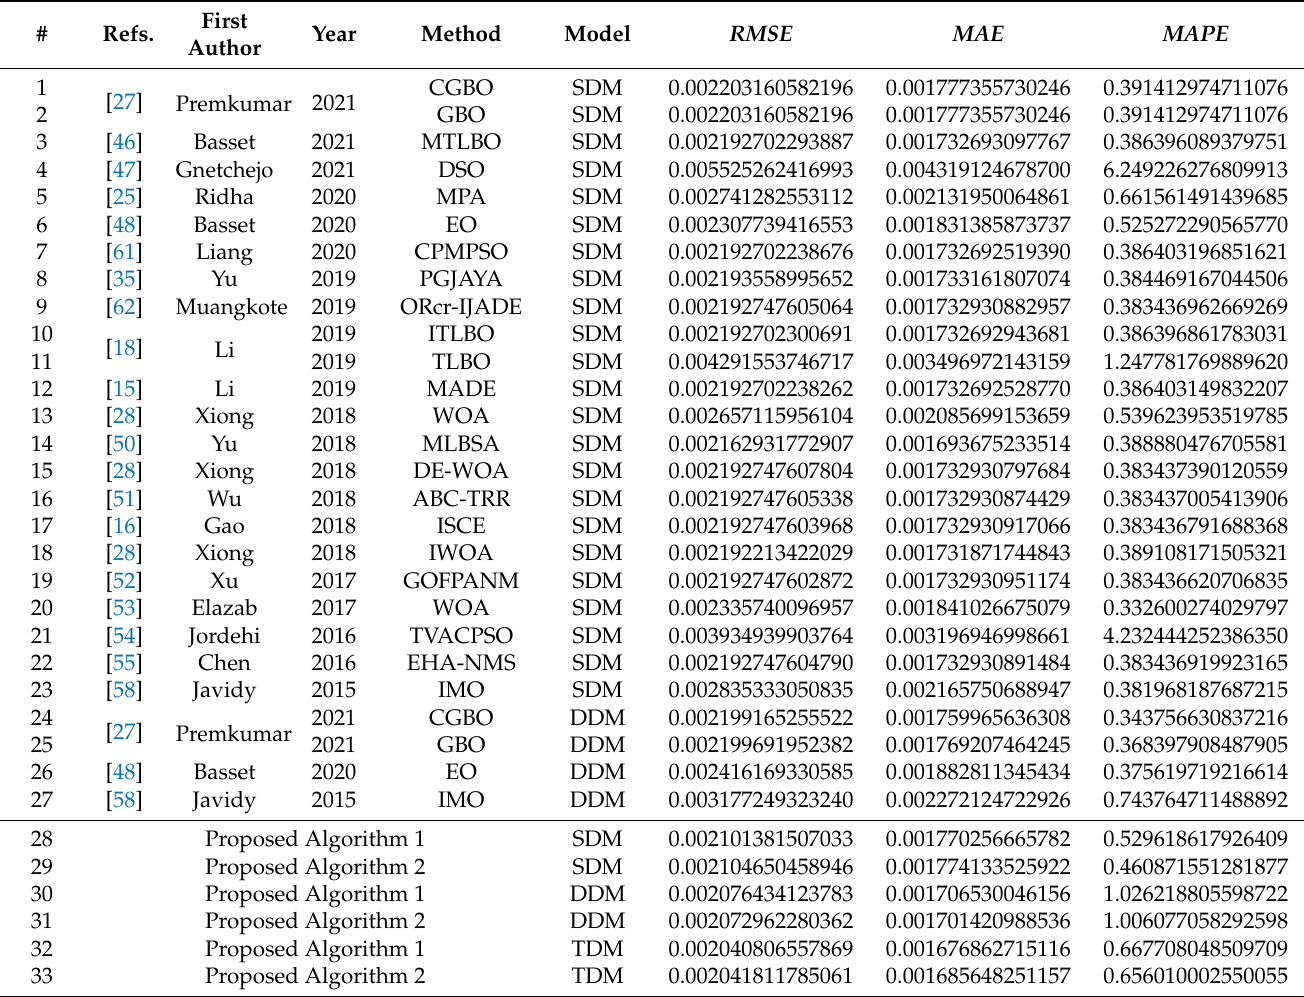
Table 5. Numerical results obtained for the Photowatt-PWP201 module.